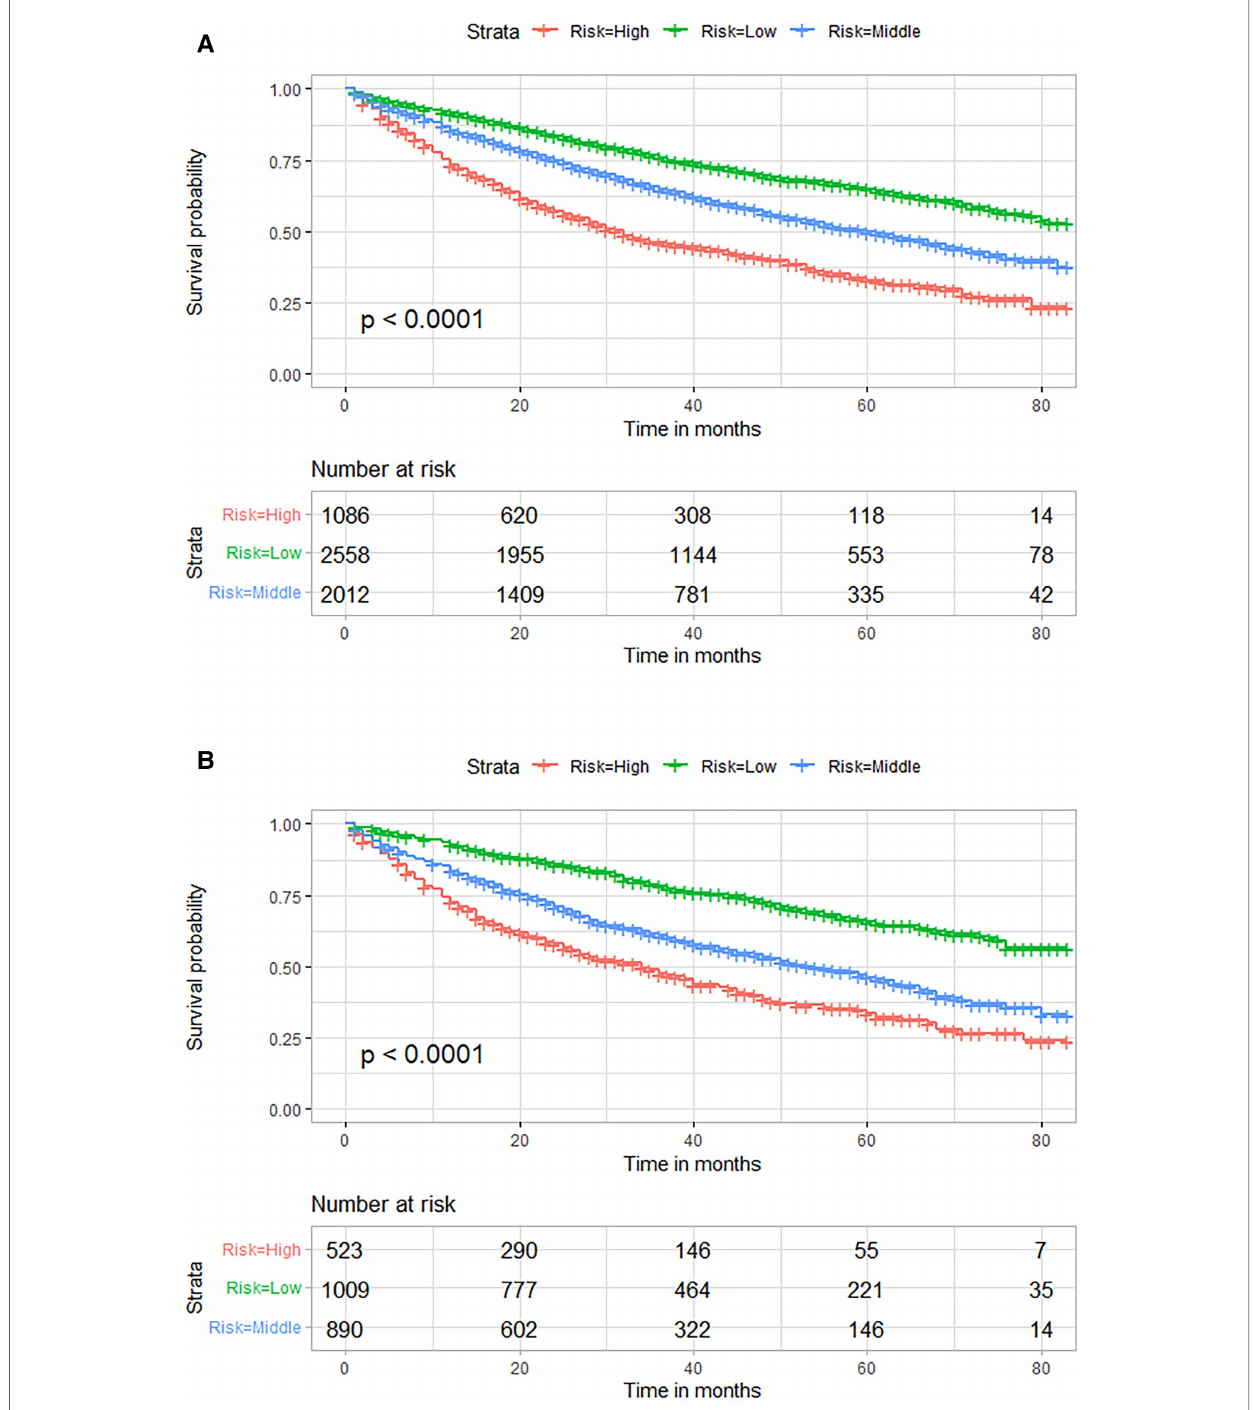
FIGURE 5 Kaplan – Meier OS curves for risk strati fi cation based on total nomogram scores in the training ( A ) and external validation ( B ) cohorts. OS, overall